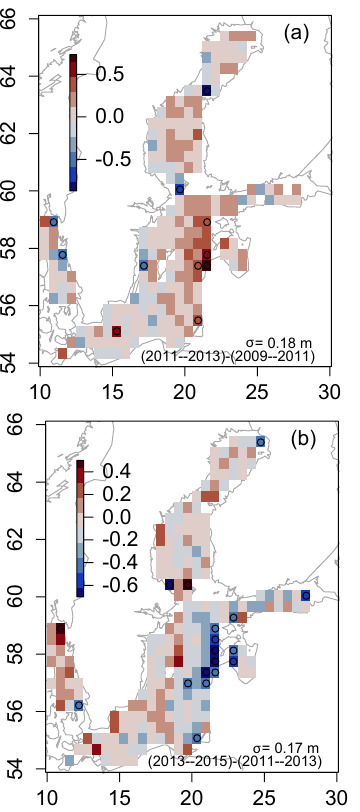
Figure 7. Comparison of average annual SWH obtained using vi- sual observations (circles) at Liep¯aja (a) and Ventspils (b) and multi-mission altimetry data (diamonds, shifted down by 0.4m to ease a